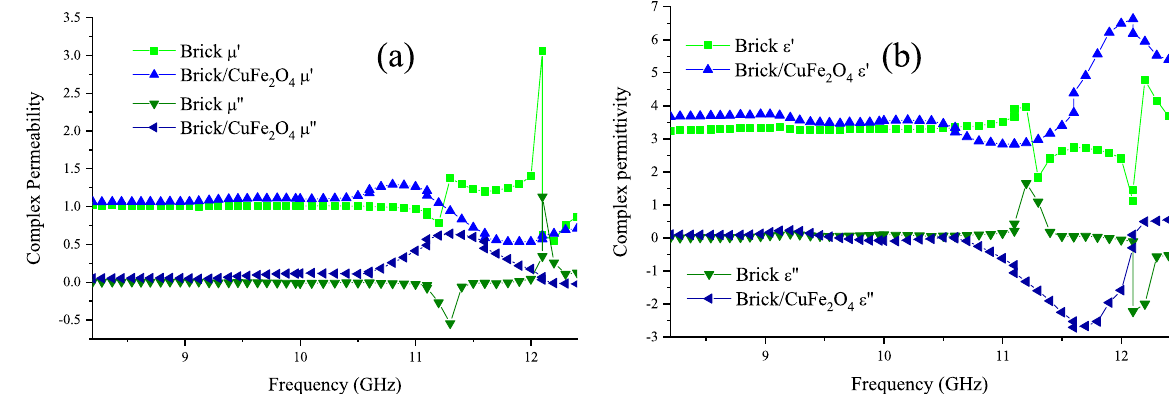
Figure 10. Frequency dependence of complex permeability ( a ) and permittivity ( b ) of the brick and brick/ CuFe